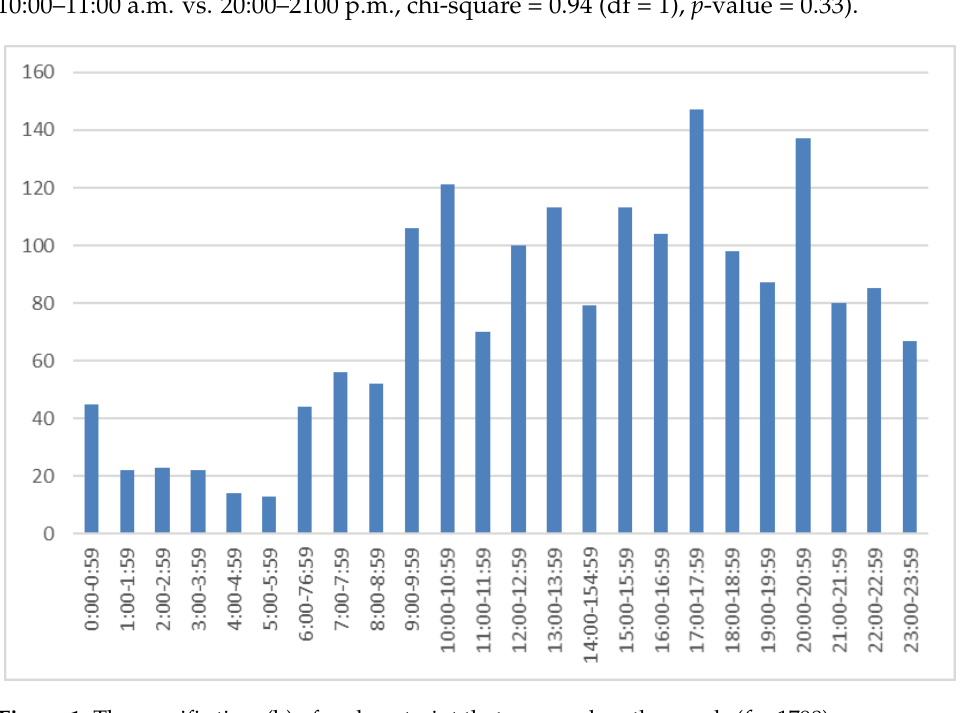
1986 f = frequency; % = percentage . The length of each restraint type for separate incidents was analysed. About half of all the physical restraint incidents took 1 – 2 h (52.23%), and seldom lasted less than one hour (5.24%). Only two incidents took more than four hours (Table 3). 3.4. Reasons for Physical Restraint and Alternative Methods Overall, a total of 2122 reasons or indications were given for physical restraint events. As more than one reason could be attributed to each incident, the total number of reasons was higher than the total number of incidents. The reasons for physical restraint included violent behaviour (f = 990, 47%), self-harm (f = 122, 6%) and absconding (f = 109, 5%). Other reasons were also reported (f = 901, 42%), such as poor self-control, agitated mood, or displayed temper. Over 4517 alternative methods were used before physical restraint